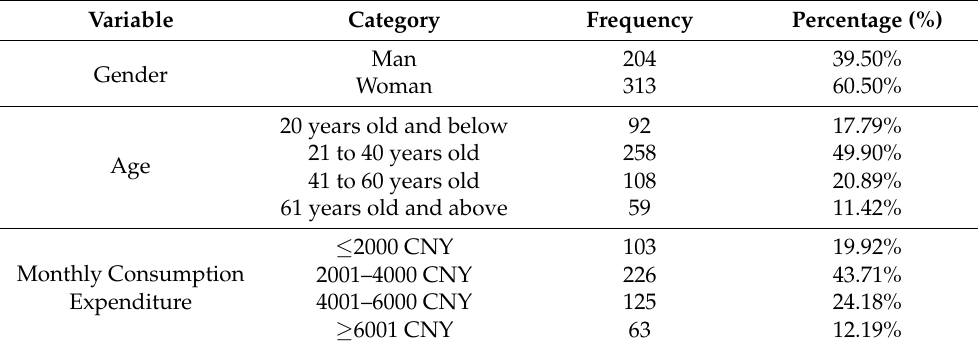
Table 1. Table 1. Respondents’ demographic information.